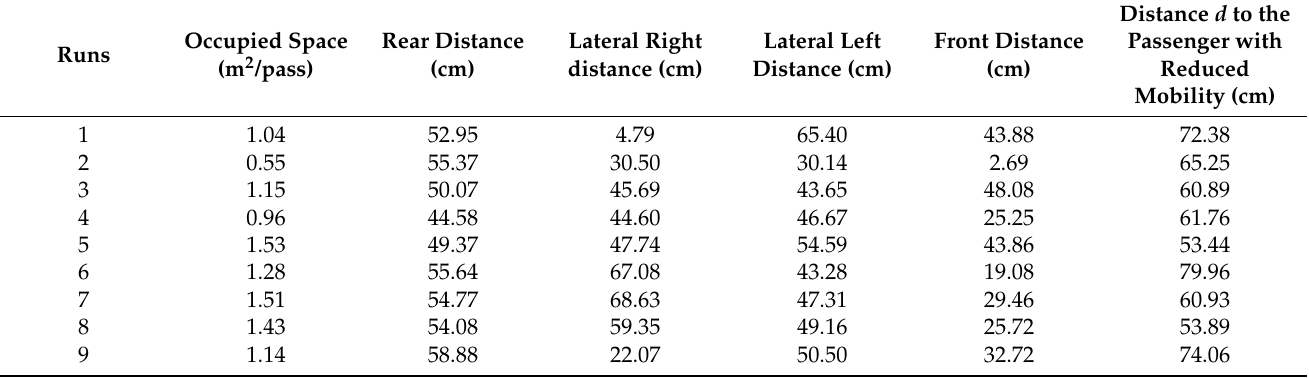
Table 3. Average space occupied by an elderly passenger waiting to board the